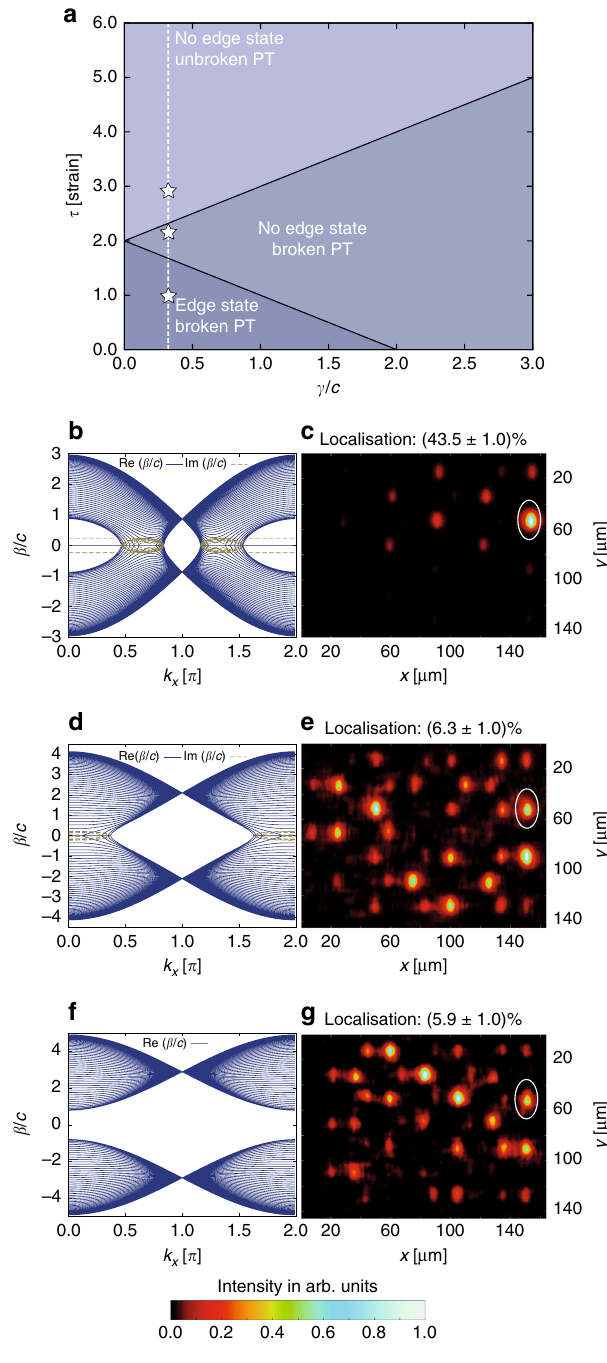
Fig. 4 Demonstration of the topological transition in the PT -symmetric structure. a The τ – γ phase diagram shows three distinct phases associated with the strain and loss parameters of our structure. The three stars correspond to the parameters used in ( b ) – ( g ). b For a strain of τ < 2 (cid:2) γ c , the system is in the broken PT -symmetric phase and topological mid-gap states are present. In the left panel, the corresponding dispersion relation is shown. c Experimental image at the sample output facet, where light was injected into the marked edge waveguide and remains close to the edge as the mid-gap state exists. The ratio of light in the marked waveguide in proportion to the intensity of all waveguides is about 43.5%. d For an intermediate strain 2 (cid:2) γ c < τ < 2 þ γ c , the system is still in the broken PT -symmetric phase, but the topological mid-gap states cease to exist. In the left panel, the corresponding dispersion relation is shown. e Experimental image at the sample output facet, where light was injected into the marked edge waveguide and spreads into the bulk as no mid-gap state exists. The ratio of light in the marked waveguide in proportion to the intensity of all waveguides is about 6.3%. f For suf fi ciently strong strain τ > 2 þ γ fi nally driven into the unbroken PT -symmetric c , the system is phase, where no topological mid-gap states exist either. In the left panel, the corresponding dispersion relation is shown. g Experimental image at the sample output facet, where light was injected into the marked edge waveguide and spreads into the bulk as no mid-gap state exists. The ratio of light in the marked waveguide in proportion to the intensity of all waveguides is about